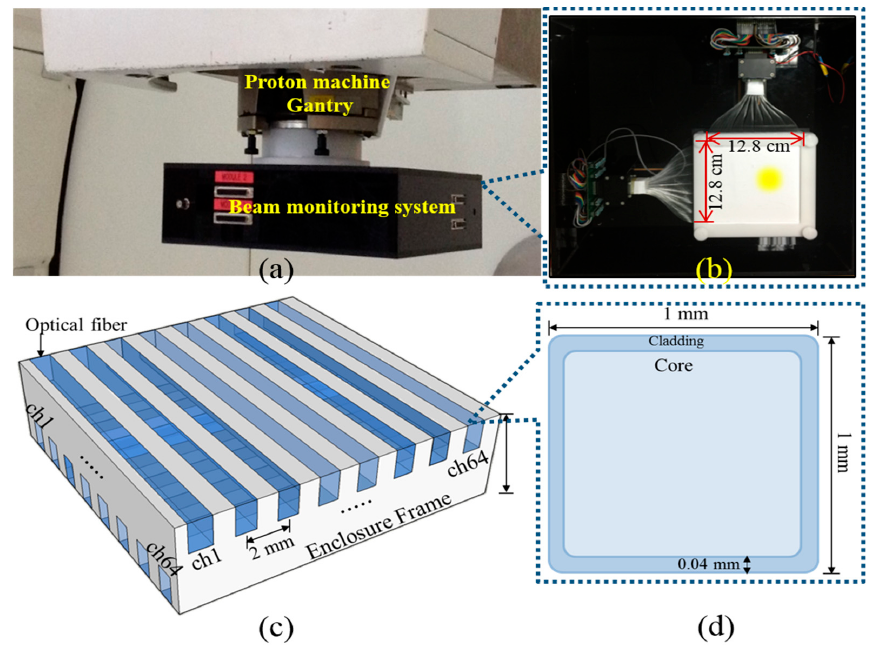
Figure 2. ( a ) Configuration of the developed FORS based proton beam dosimetry system; ( b ) The inside view of the developed proton beam dosimetry system; ( c ) Schematic image of the side-view of the FORS; ( d ) Schematic image of cross-section of the optical fiber.